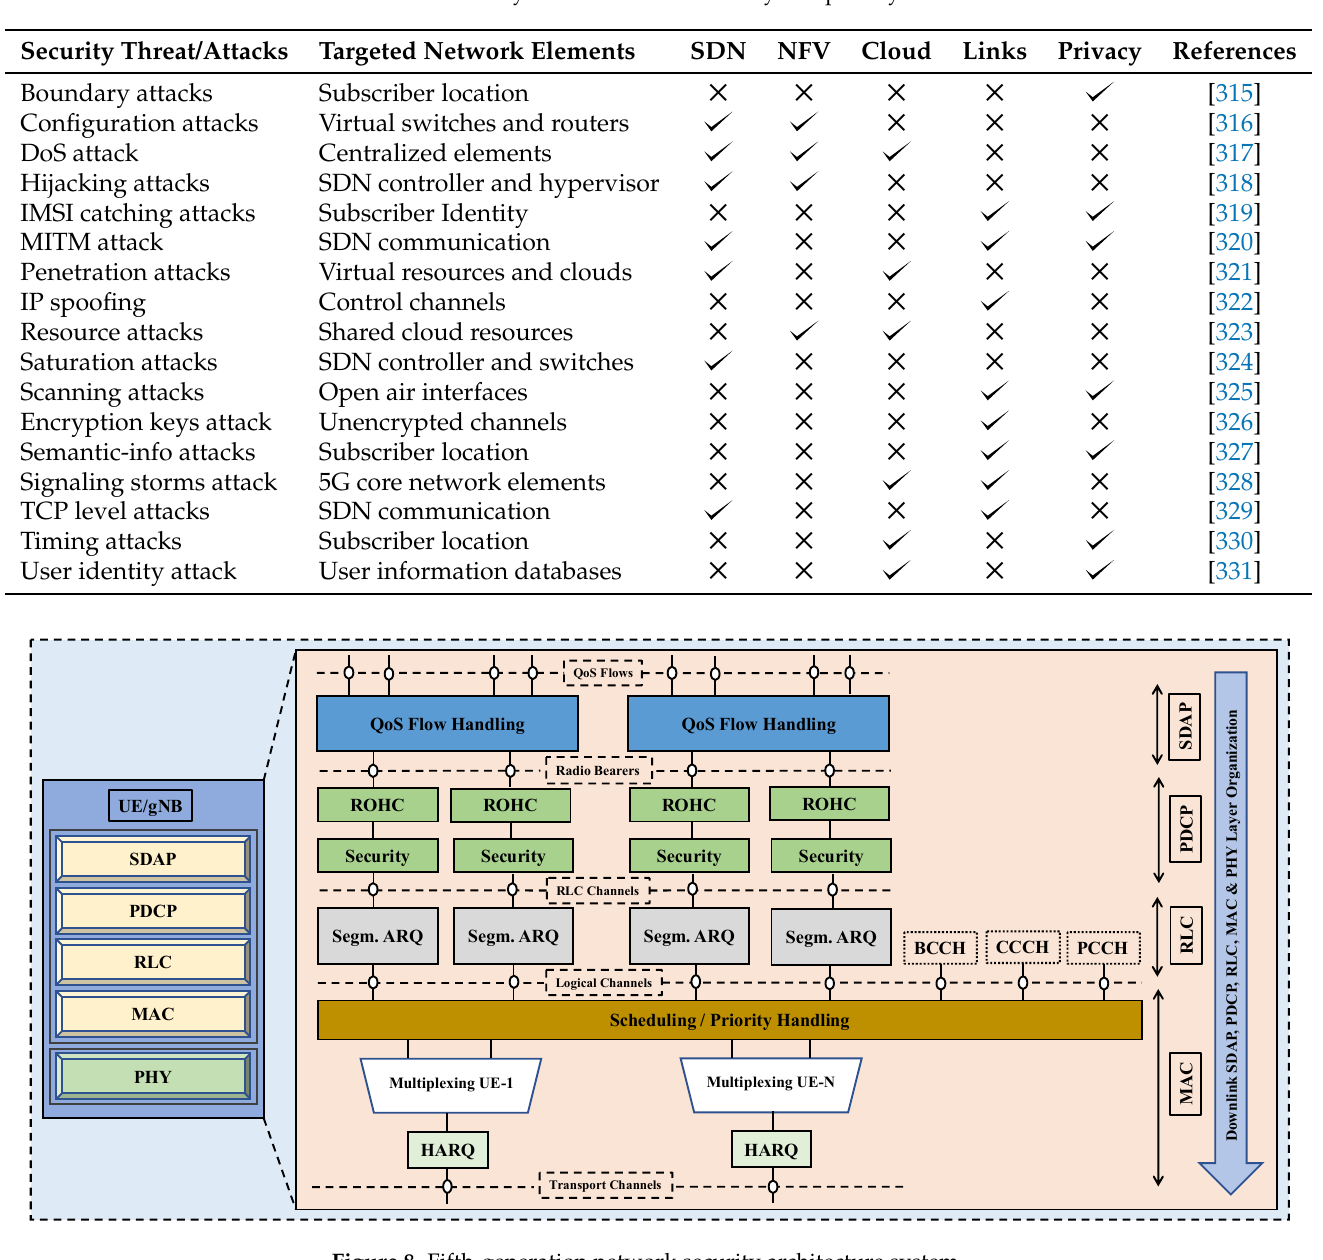
Figure 8. Fifth-generation network security architecture